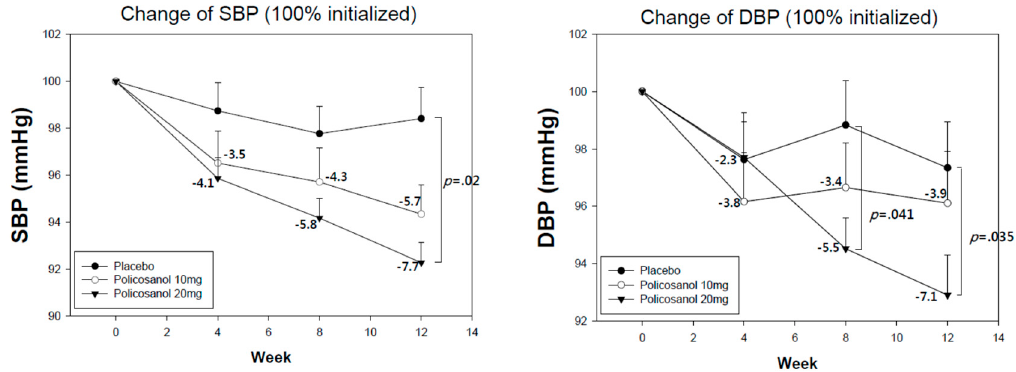
Figure 2. Change of peripheral blood pressures (SBP and DBP) during 12-week consumption of policosanol groups and placebo group from repeated measurement ANOVA. Data are expressed as mean ± SEM. SBP: systolic BP; DBP: diastolic BP; SEM: standard error of mean.